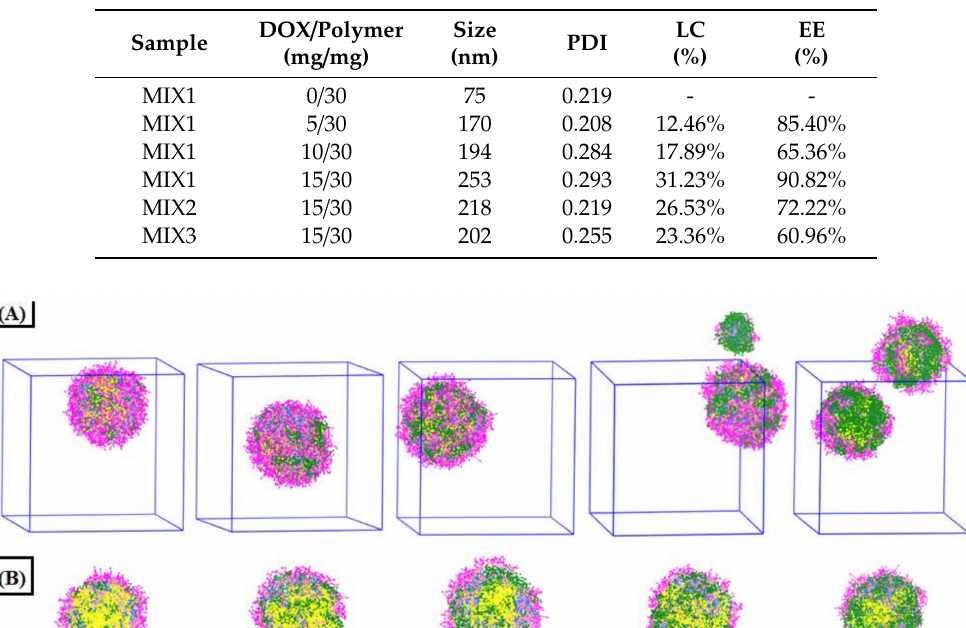
Table 2. Size, polydispersity index (PDI), loading content (LC), and encapsulation e ffi ciency (EE) of the DOX-loaded mixed micelles.